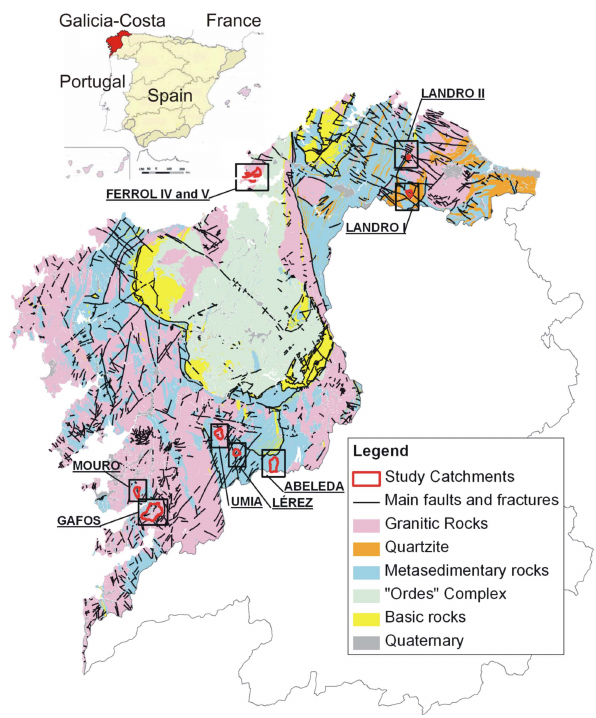
Fig. 1. Location of the hydrologic district of Galicia-Costa in the Spanish hydraulic division, the study catchments and geological map (elaborated from GEODE geological map; IGME,